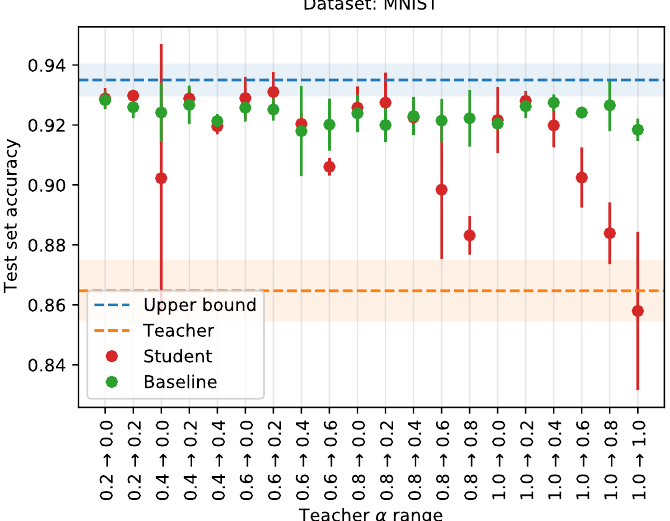
Figure 7. Training a student network with knowledge distillation, with linearly annealing values for hyperparameter α , on the 2cMNIST dataset. The range for α is given on the x-axis, while the y-axis gives the test set performance. Averages over three runs. Shaded areas and error bars indicate the standard